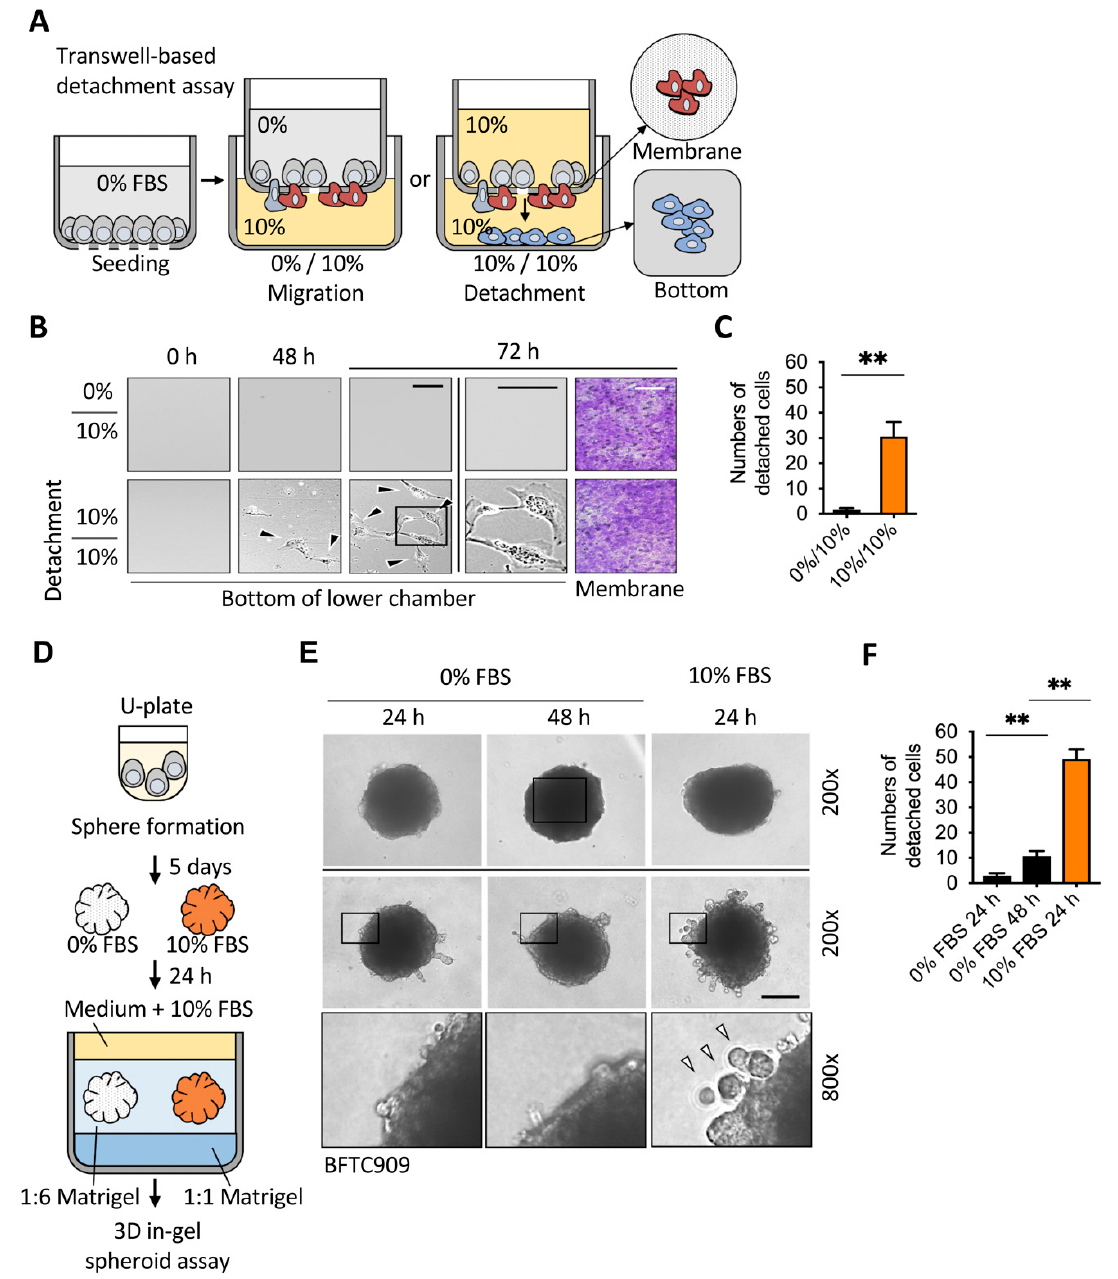
Figure 1. Detachment of invasive leading cells in the Boyden chamber and 3D in-gel spheroid detachment assay. ( A ) Schematic showing the procedure used for establishing a Boyden chamber detachment assay. ( B ) Representative images of the lower chamber demonstrated that starvation of cancer cells inhibited detachment in the leading cells. BFTC909 cells were seeded in the upper chamber overnight and the transwell assay was performed with or without serum in the upper chamber for 48 and 72 h. The membranes were stained by 1% crystal violet and the cell number from membranes or the lower chamber was determined ( B , C , respectively). Scale bars: 100 μ m. ** p < 0.01. Data are means ± s.d. (two-tailed t-test) from experiments with three replicates ( n = 3). ( D ) Schematic showing the procedure used for establishing a 3D in-gel spheroid detachment assay. ( E,F ) In vitro 3D in-gel spheroid detachment assays demonstrated that the starvation of spheres led to reduced detachment in the leading cells. BFTC909 cells were plated in a 96-well U-plate for 5 days and the spheres were embedded in Matrigel for in-gel detachment assay. Detached cells from spheres were counted after 24 or 48 h. Black and white arrow: detached cells. Scale bars: 100 µ m. ** p < 0.01. Data are means ± s.d. (one-way ANOVA with Dunnett’s multiple comparisons test) from experiments with three replicates ( n =